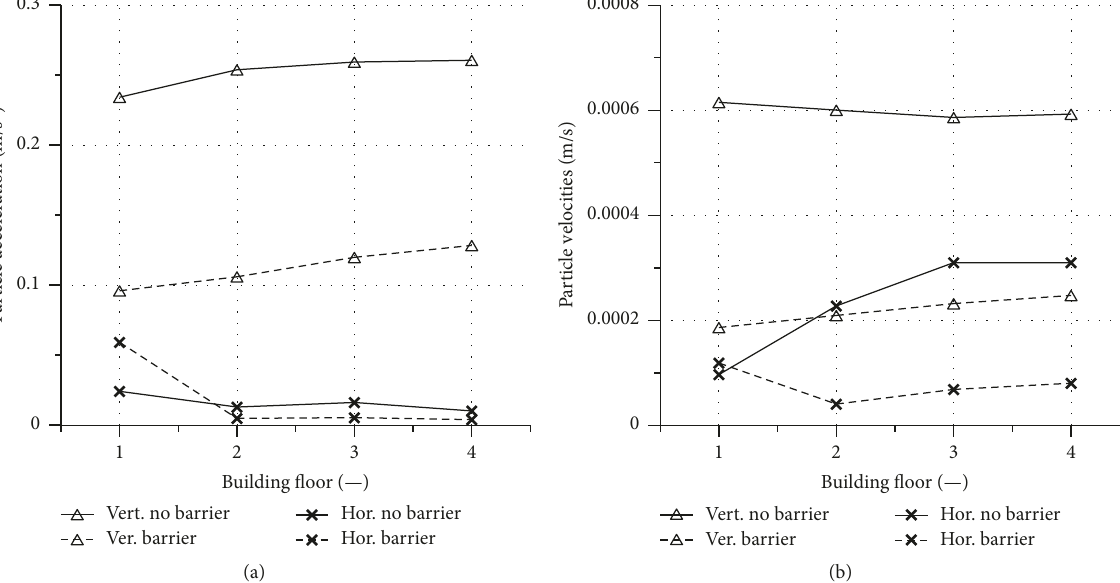
of the barrier, especially in the vicinity of the